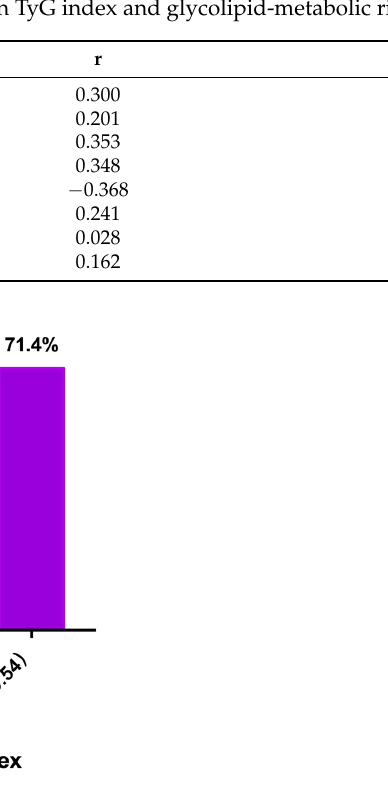
Figure 3. Prevalence of VDD across the TyG index quartiles. Comparisons of the percentages of VDD prevalence among the TyG index quartiles was performed using Chi-square test for linear trend test.